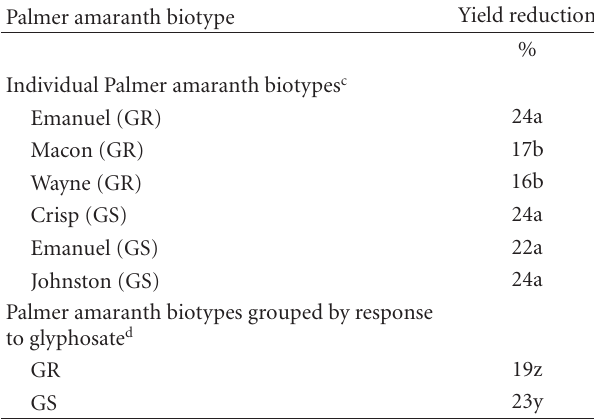
Table 3: Percent reduction in soybean yield caused by season-long interference by Palmer amaranth in field experiment. a,b